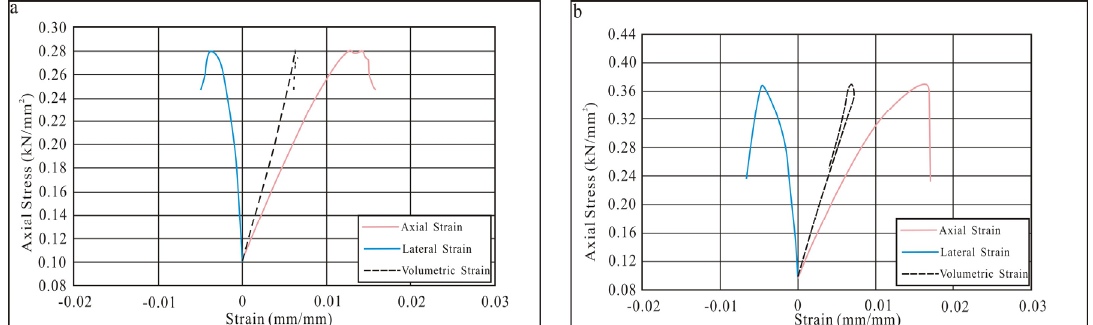
Figure 6. Stress-Strain curves for Triaxial Compressreion Tests in W206. ( a ) 3753.96–3754.22; ( b ) 3792.29–3792.53.